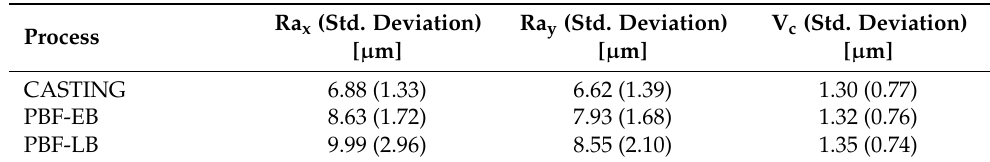
Table 4. Surface roughness average and standard deviation values for each direction and material manufacturing technology.